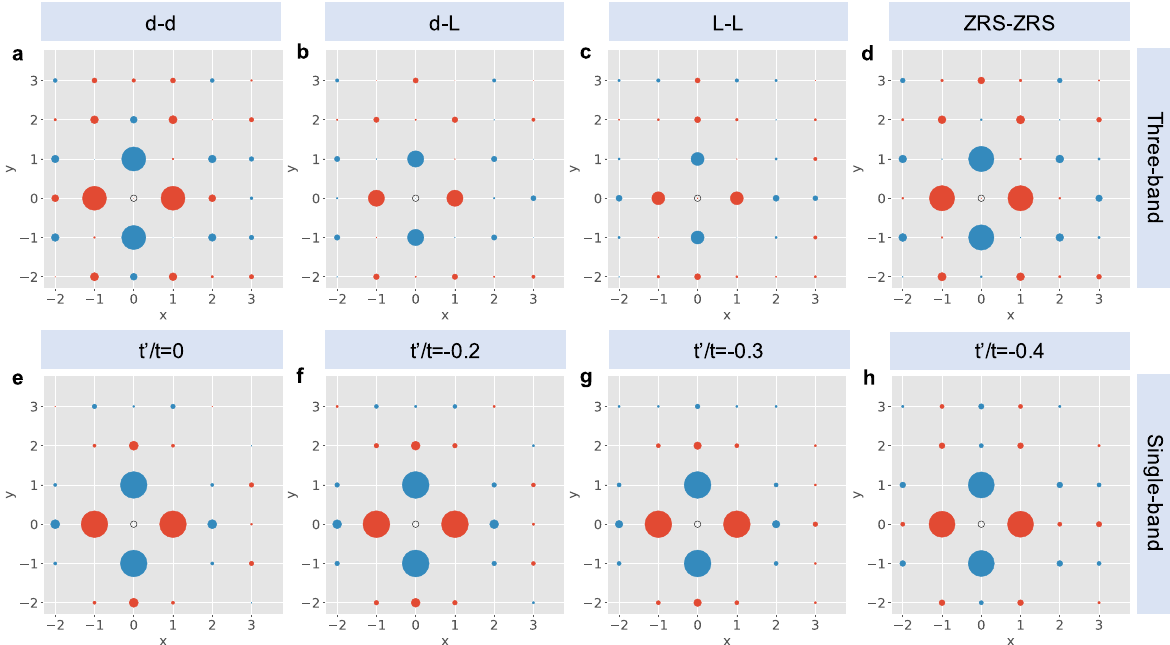
Fig. 3 A comparison of the pairing structure in the three-band and single-band models. Each panel plots the real-space components of the leading particle – particle BSE (symmetrized) eigenvector at 15% hole doping. The fi rst row shows d – d , d – L , L – L, and ZRS – ZRS pairing components for the three-band model at β = 10 eV − 1 . The second row shows the pair structure for the single-band model ( U = 6 t , β = 5 t − 1 ) at t 0 = t ¼ 0 , − 0.2, − 0.3, and − 0.4.